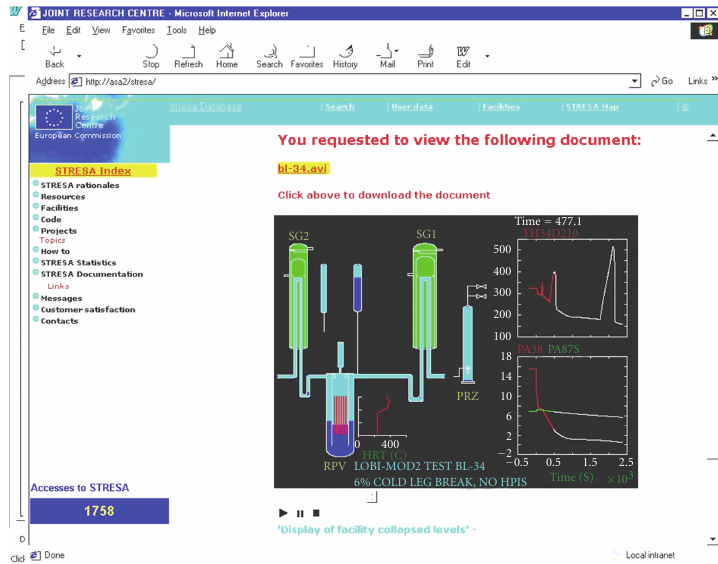
Figure 6: Display of collapsed liquid levels, heater rod temperature, and system pressures at 477 s into a 6% SBLOCA.